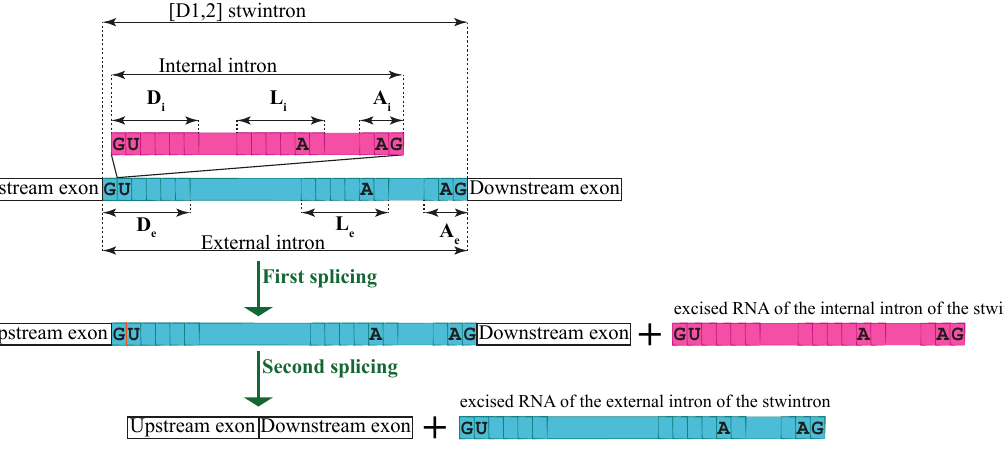
Figure 1. Structure and nomenclature of stwintrons and their typical stepwise excision. ( a ) A stwintron is a complex intervening sequence that consists of two nested canonical introns, which are excised by two subsequent standard U2 splicing reactions in “inside out” order [11]. There are four classes of stwintron, depending on which of the canonical sequence elements of the external U2 intron is disrupted by the internal U2 intron: (D), donor-disrupted; (L), BP element- disrupted; (A), acceptor-disrupted; (sensu lato), canonical intron within canonical intron, the former not included in (D), (L) or (A). ( b ) In a (D1,2) stwintron, an internal U2 intron (magenta) is nested within the 5 (cid:48) -donor element (D) of an external U2 intron (turquoise) between the first and the second nt of that donor element (5 (cid:48) -G 1 |U 2 ). Removal of the internal intron from the pre-mRNA generates a functional donor for the external intron necessary for the excision of the latter; (D1,2) stwintrons in pre-mRNAs thus start with 5 (cid:48) -GGU (occasionally, 5 (cid:48) -GGC). The existence of the RNA intermediate of the consecutive U2 splicing reactions, which lacks the internal but still contains the external intron, can be experimentally verified. 5 (cid:48) -Donor, lariat branch point (BP) sequence element and 3 (cid:48) -acceptor of both constituent introns of the (D1,2) stwintron are annotated D i , L i and A i , and D e , L e and A e , respectively. Note that if the first exonic nt downstream of a (D1,2) is a G, the complex intervening sequence can be alternatively excised as an (A2,3) stwintron, in which the constituent introns swap order